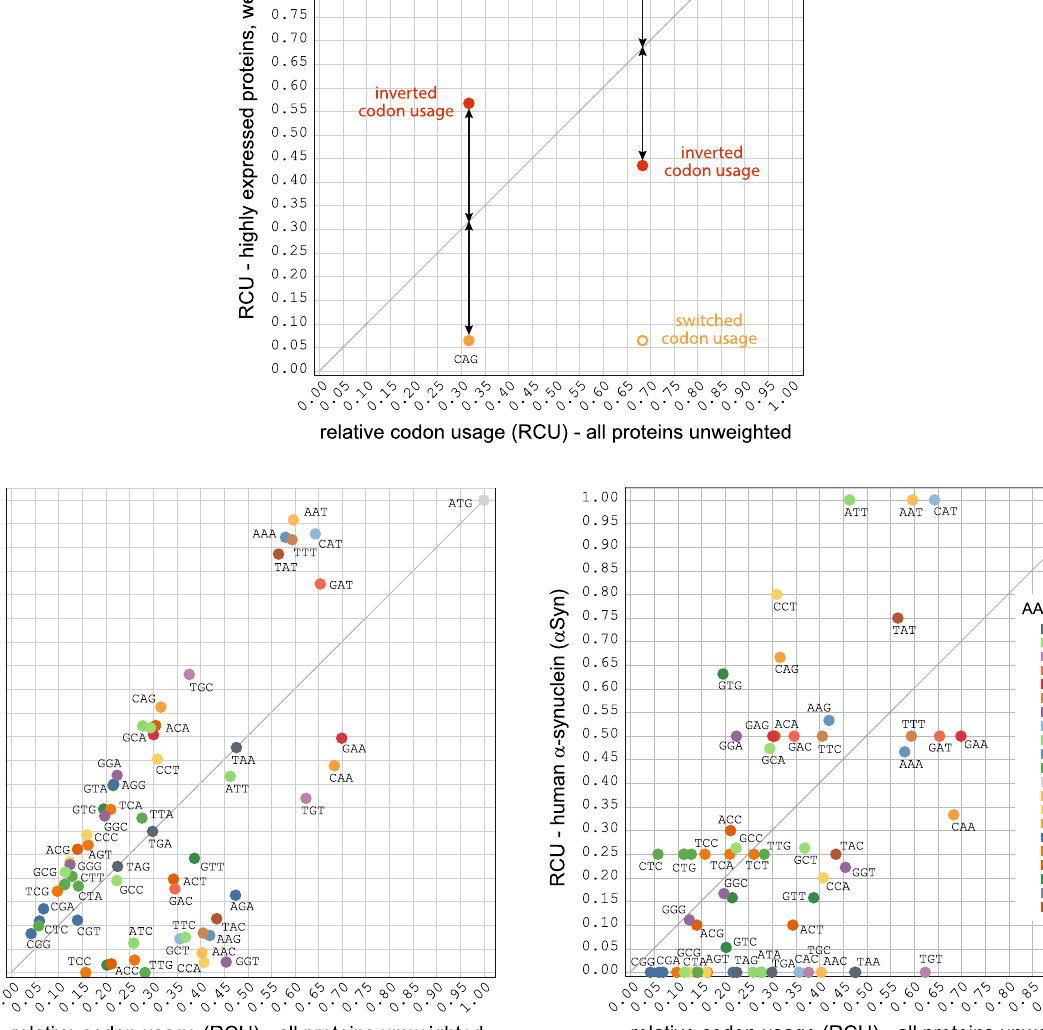
expressed genes but that of all genes, which rather resembles the usage of the lowly expressed genes. For example, the Gene Designer v1 software (the algorithm of v2 is not published and could be different) uses the frequency distribution for each codon box based on a codon usage table, which according to the online documentation does not correspond to the usage of the highly expressed genes in yeast 49 . The tool OPTIMIZER allows the upload of a user-provided codon usage table and selection of always the most used codon, random selection by frequency distribution or manual selection of codons 50 . In a very recent approach, ChimeraUGEM, a target gene is designed by comparing its protein sequences by a longest substring approach to a set of reference sequences assuming that longer repetitive substrings became more optimized to the hosts translation machinery 51 . The algorithm has been used for predicting gene expression levels, and has also been shown to be successful in increasing expression of a synthetic gene in green algae. The ChimeraUGEM approach seems to be most related to our typical gene approach, although ChimeraUGEM designs the genes substring by substring (not overlap- ping) and does not explicitly aim to optimize di-codons. Limitations of the odysseus implementation. It is well known that there is additional information in the coding sequence of a gene beyond the genetic code for translating nucleotide triplets (codons). For example,